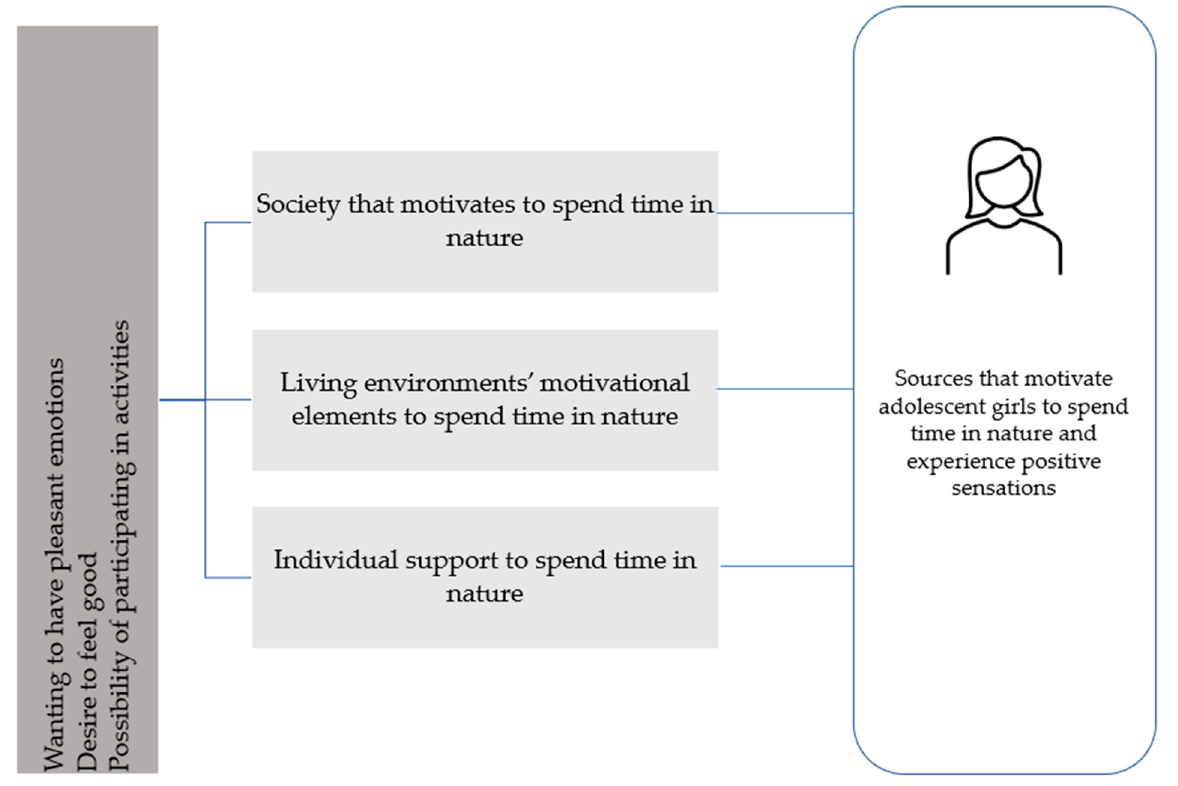
Figure 3. Summary of motivational elements and how to motivate adolescent girls to spend time in nature.